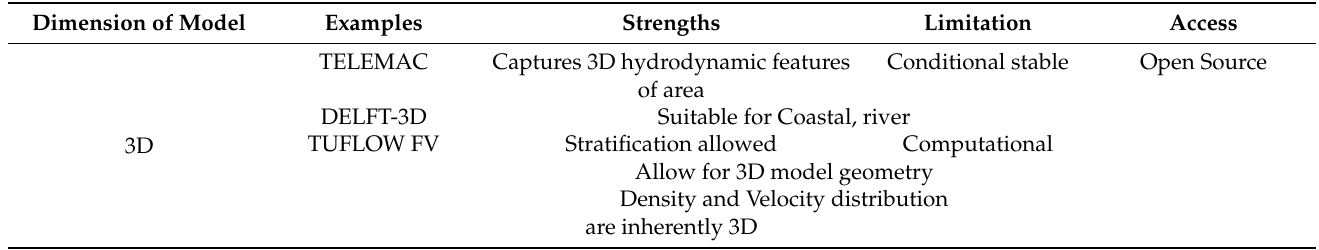
Table A3. Summary of the three-dimensional (3D) numerical tool in flood modelling.